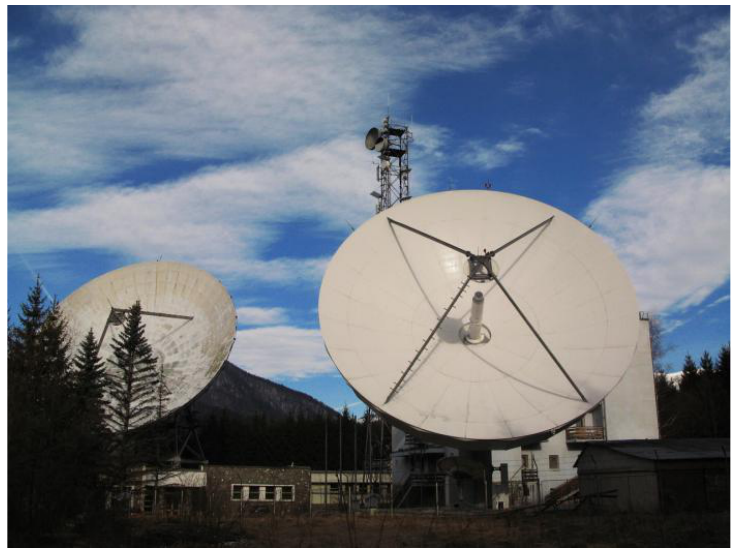
Figure 3. The two antennas at Cheia Satellite Communications Center.